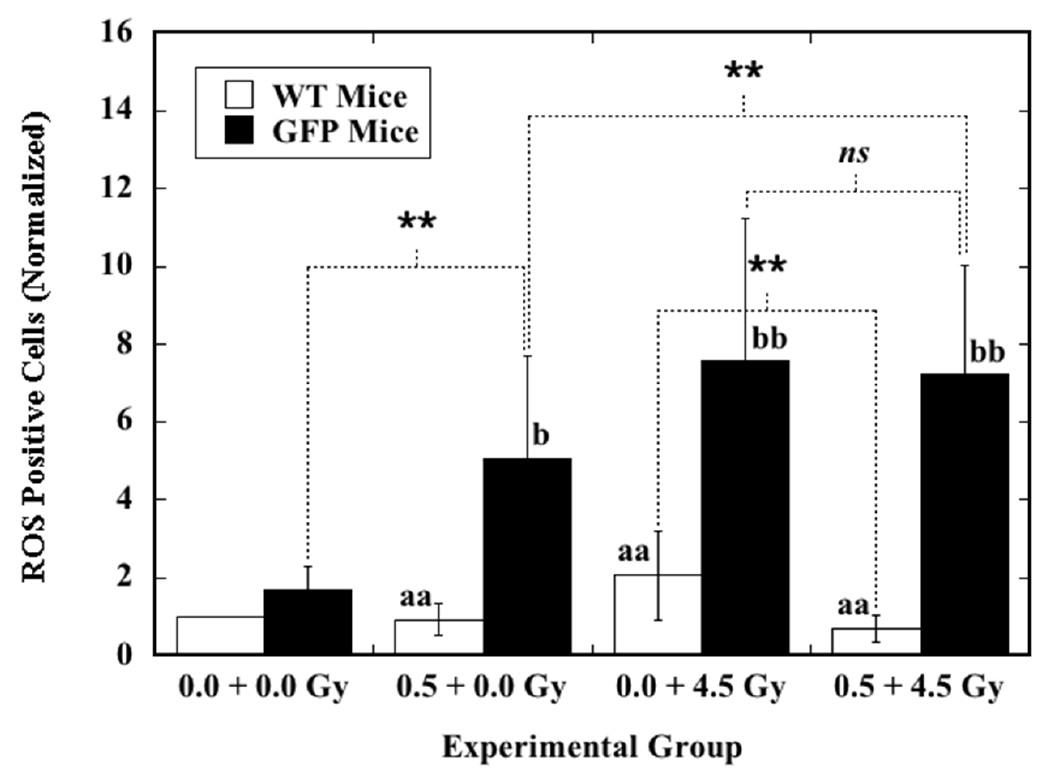
Figure 2. The effect of priming TBI at six postnatal weeks on ROS induction by ex vivo X-irradiation in the hematopoietic cells from mice at eight postnatal weeks. The animals were irradiated with a priming dose of 0.5 Gy or sham-irradiated (0.0 Gy) at six postnatal weeks. Nucleated bone marrow cells collected from the animals at eight postnatal weeks were irradiated (4.5 Gy) or sham-irradiated (0.0 Gy) with X-rays, and induction of ROS was measured. “0.0 + 0.0 Gy” represents the cells from mice receiving sham-irradiation at six postnatal weeks and being sham-irradiated ex vivo. “0.5 + 0.0 Gy” represents the cells from mice receiving a priming dose of 0.5 Gy at six postnatal weeks and being sham-irradiated ex vivo. “0.0 + 4.5 Gy” represents the cells from mice receiving sham-irradiation at six postnatal weeks and being irradiated with 4.5 Gy ex vivo. “0.5 + 4.5 Gy” represents the cells from mice receiving a priming dose of 0.5 Gy at six postnatal weeks and being irradiated with 4.5 Gy ex vivo. Data are presented as ratios normalized to the ROS results of the cells from WT mice receiving sham-irradiation at six postnatal weeks and being sham-irradiated ex vivo. Two asterisks (**) indicate a statistically significant difference (** p < 0.01) between the two groups that were compared. Letters “ ns ” indicate no statistically significant difference between the two groups that were compared. For comparison of the irradiated group to the sham-irradiated control in WT mice, two letters “aa” stand for statistically significant differences at p < 0.01. For comparison of the irradiated group to the sham-irradiated control in GFP mice, one letter “b” and two letters “bb” stand for statistically significant differences at p < 0.05 and p < 0.01,